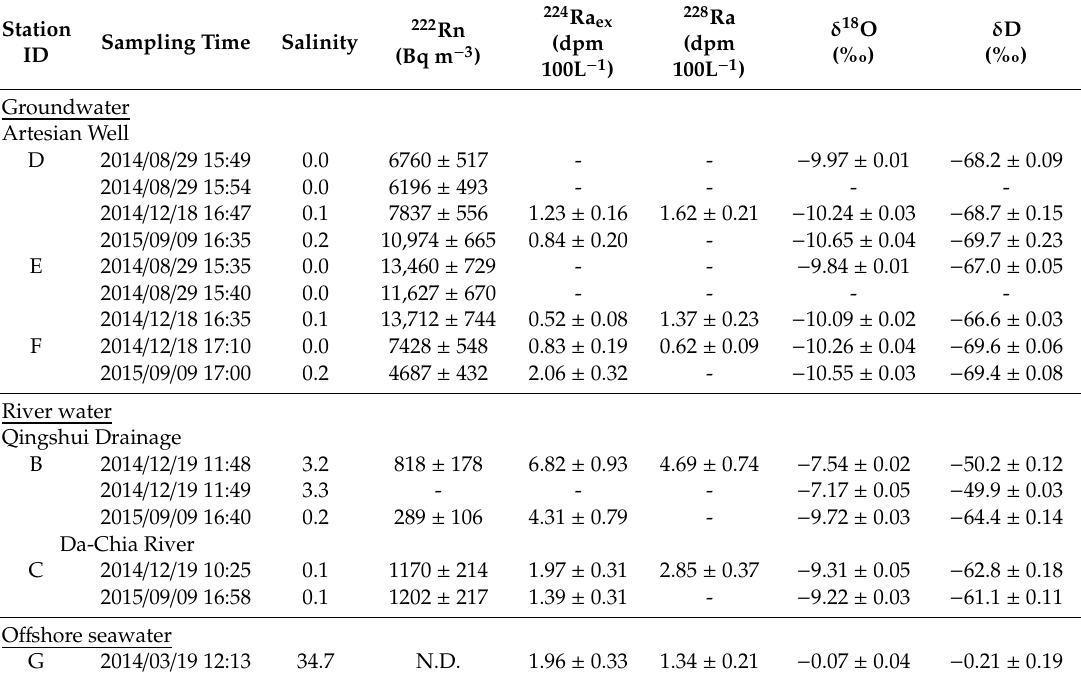
Table 1. Salinity, 222 Rn, 224 Ra ex , 228 Ra, δ 18 O, and δ D in the samples of groundwater, river water and o ff shore seawater (“-“: No data and N.D.: lower than limit of